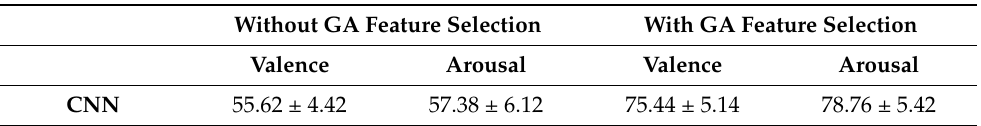
Table 5. Comparative accuracy results of the LOOCV experimental setup with and without the use of GA-based feature selection. The results refer to the mean and standard deviation of the accuracy results across all